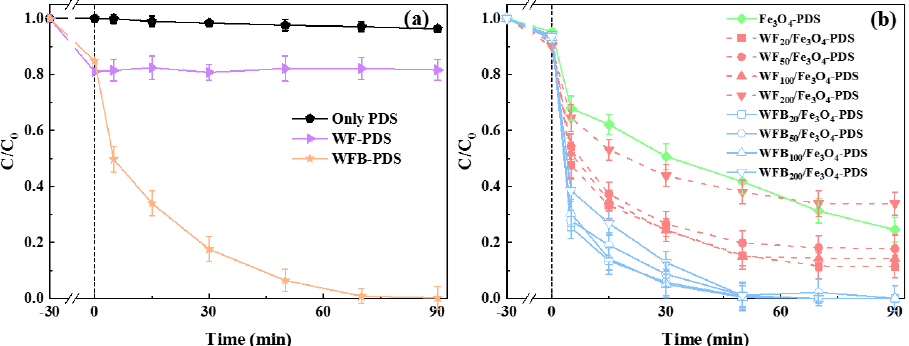
Figure 4. ( a ) The BPA removal performance in control processes; ( b ) the BPA removal performance in different Fe 3 O 4 -containing processes (conditions: [BPA] 0 = 0.02 mM, catalyst 1.0 g/L, [PDS] 0 = 5.0 mM, pH 0 = 3.00 ± 0.1). Table 1. Comparison of the BPA degradation efficiency in different